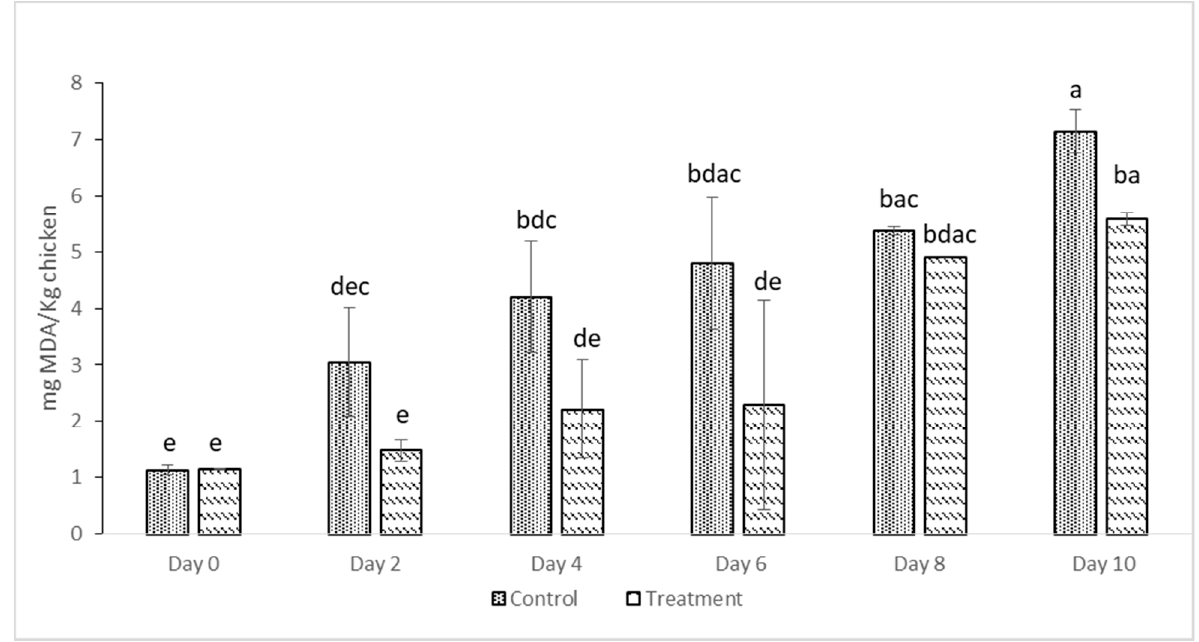
Figure 2. Thiobarbituric acid reactive substances (TBARS) values of control and treated deep-fat-fried chicken drumsticks for 10 days. Data are given as means values ± SD. Different letters on the top of data bars indicate significant differences (Tukey’s test, p < 0.05) between mean values.